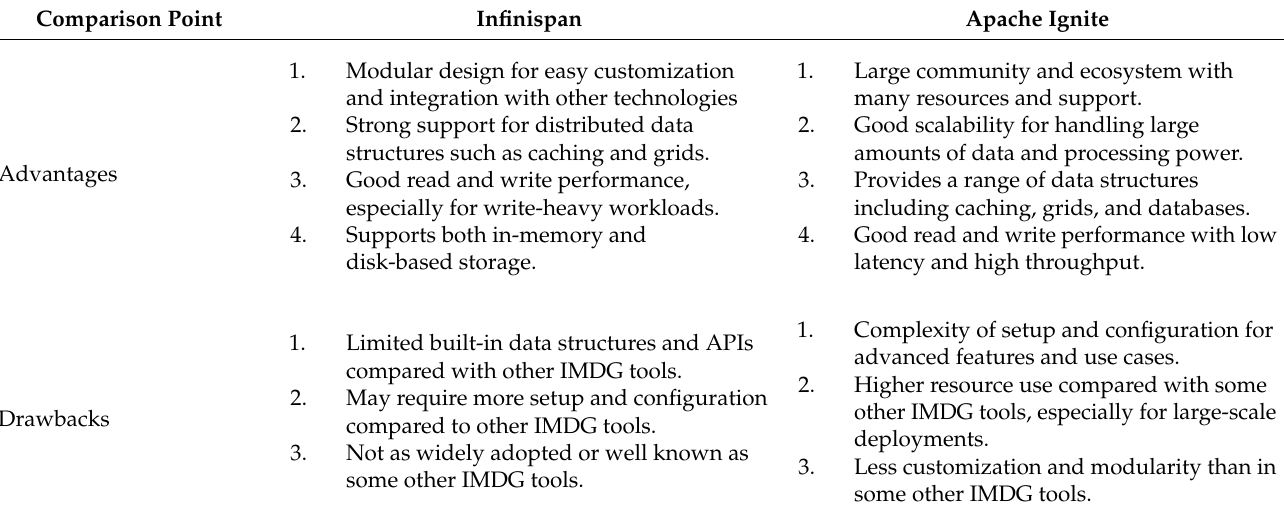
Table 2. The advantages and drawbacks of Infinispan and Apache Ignite